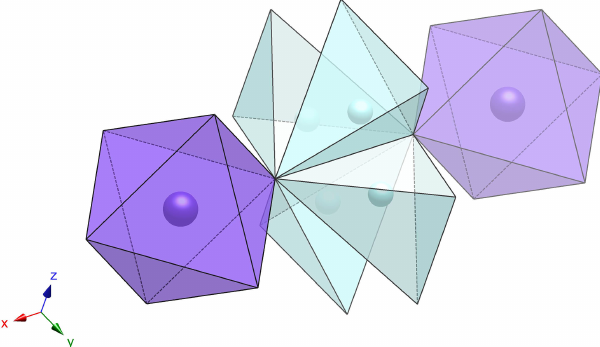
Figure 4. Connection of two Fe-centred octahedra by means of a molybdate group, which may statistically occur in four possible ori- entations.